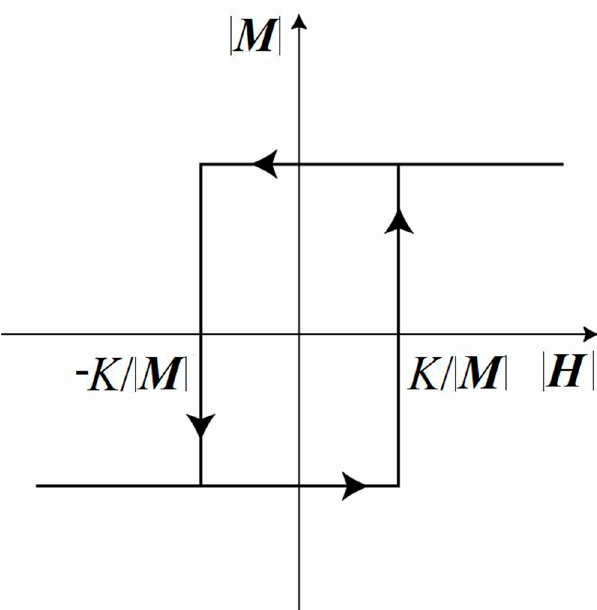
Figure 4. Magnetic hysteresis describing the moment’s | M | dependence on the applied field strength | H | is shown on the basis of the anisotropic energy guided by Equation (9).